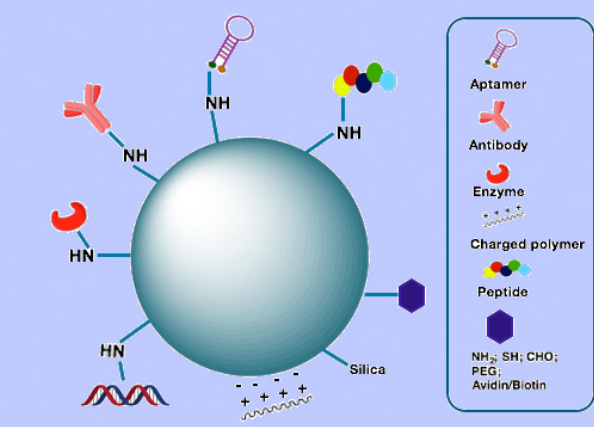
Fig. 4. Schematic illustration of the surface functionalization of SNP with, peptides, antibodies, aptamers, enzymes, DNA fragments and other functional